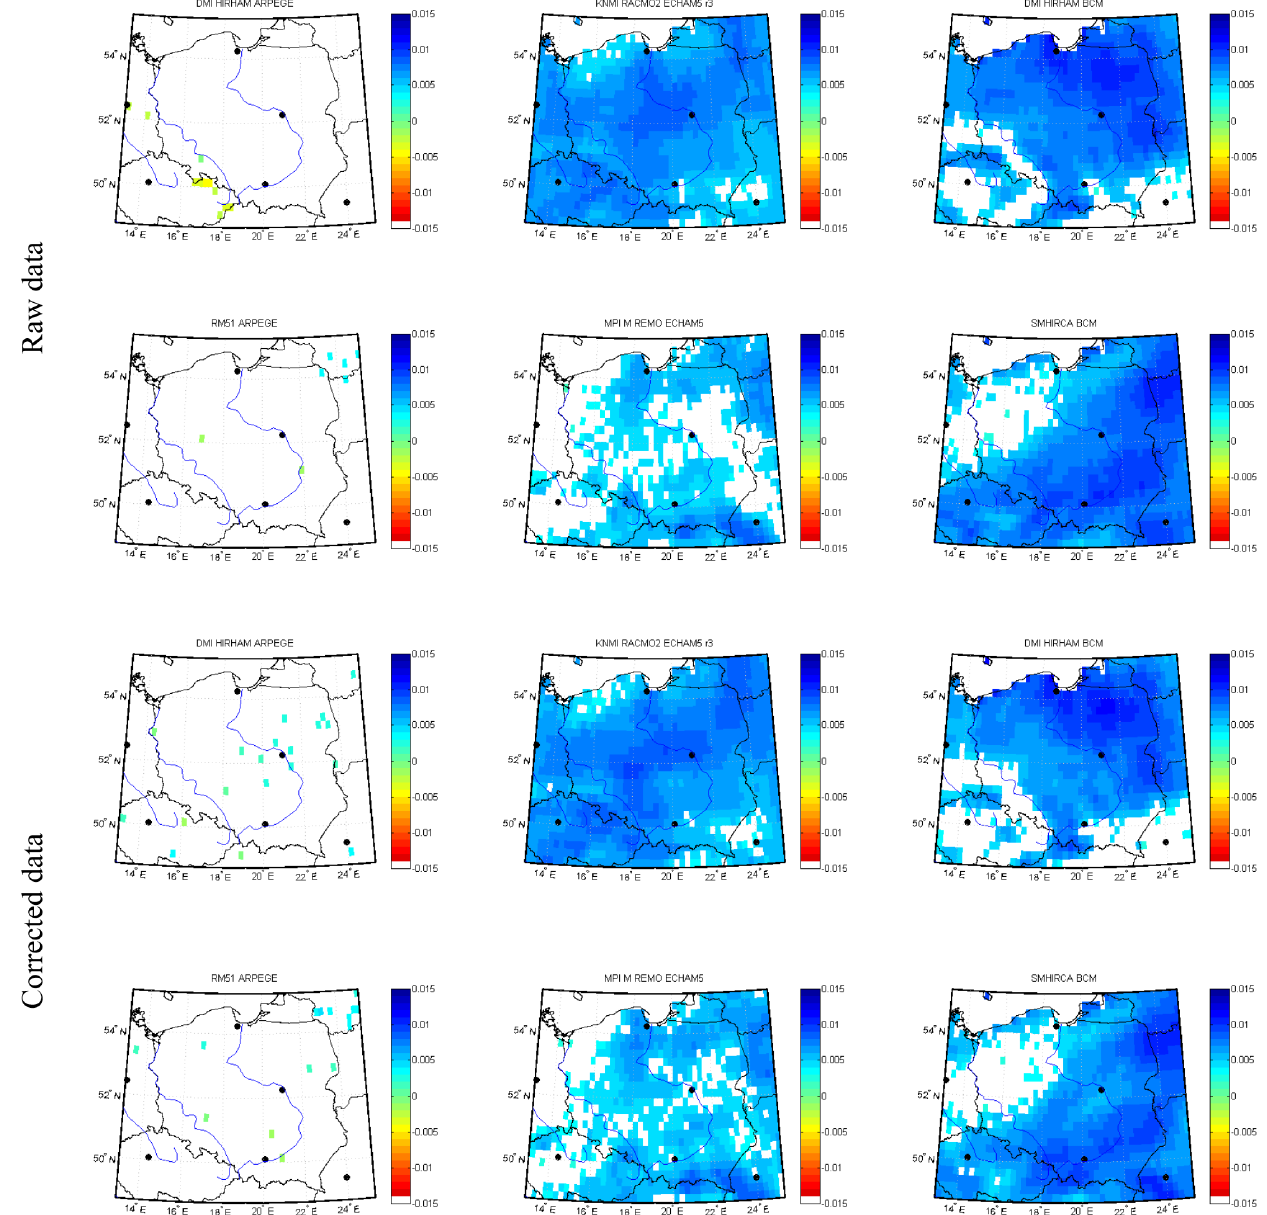
Figure 8. The results of the Mann–Kendall trend analysis for SPI 1 for January. The colour scale denotes the slope of the estimated trend. White colour indicates a lack of a statistically significant